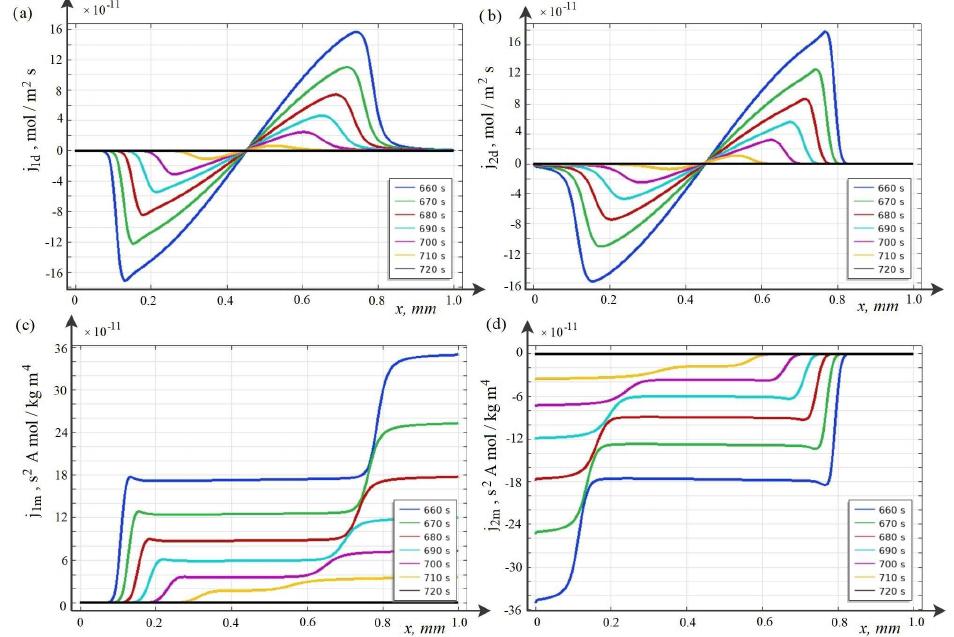
Figure 6. Graphs of diffusion ( a , b ) and migration ( c , d ) fluxes of K + and Cl − ions at different points in